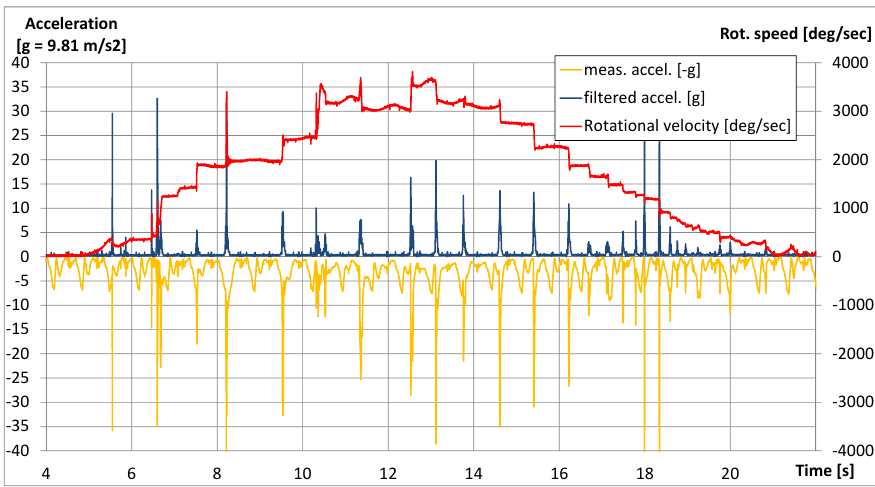
Figure 15. Example (Test 67) of the effect of accelerometer position eccentric to the centre of mass of the block: during high rotational speeds the acceleration is high during airborne jumps. Measured acceleration is transformed (multiplied by − 1) and shown on the negative scale to improve the readability of the